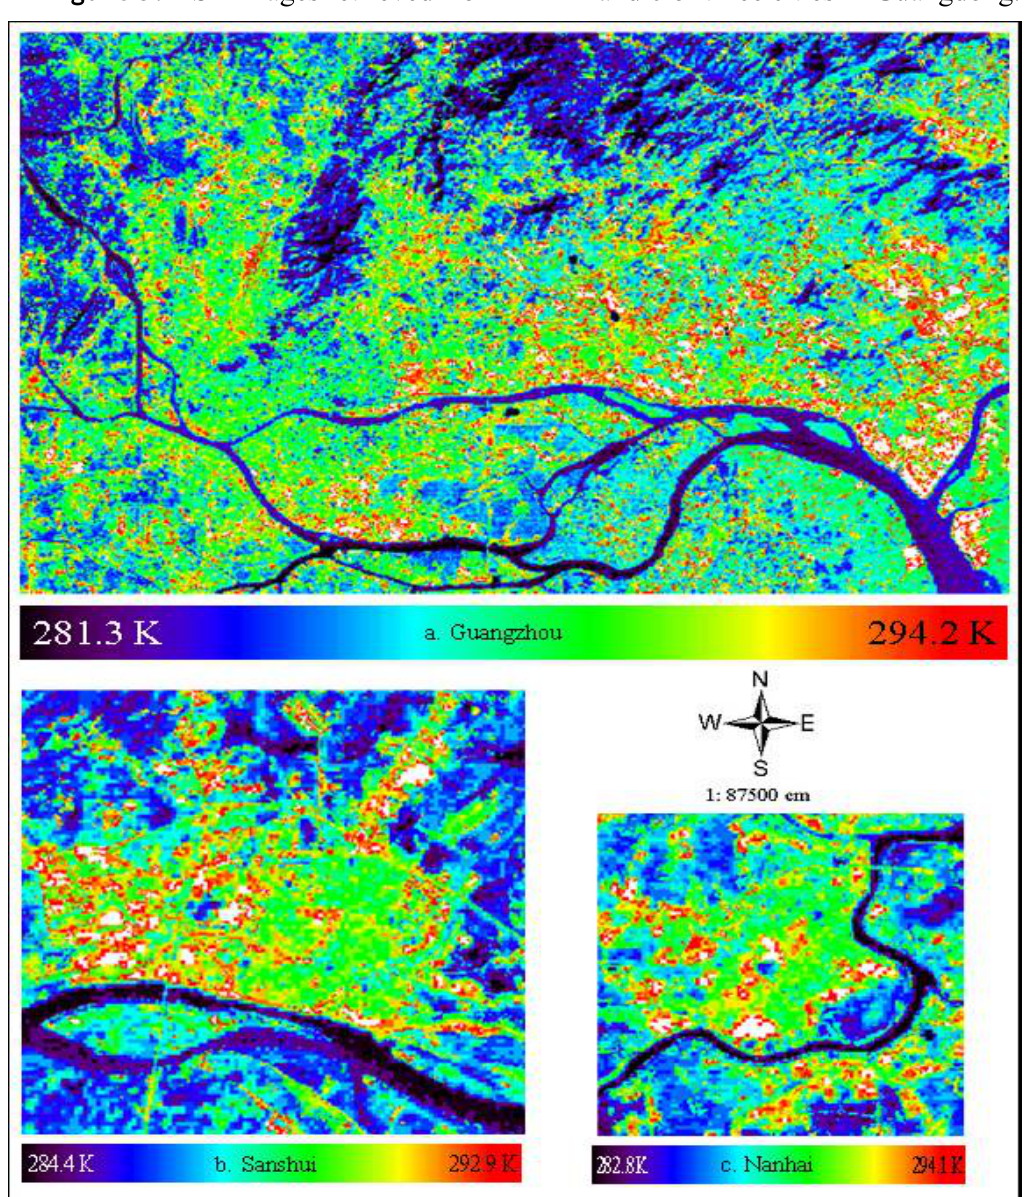
Figure 3. LST images retrieved from ETM Band 6 of three cities in